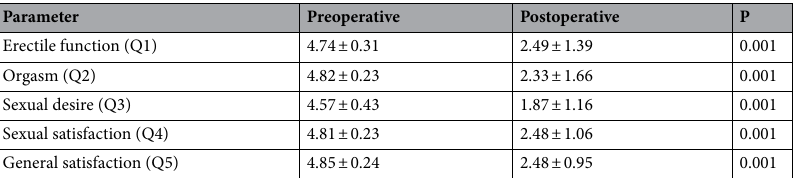
Table 3. Comparative analysis of male sexual function scores (mean ± standard deviation of mean) of the international index of erectile function domains. P significance related to paired t-test.